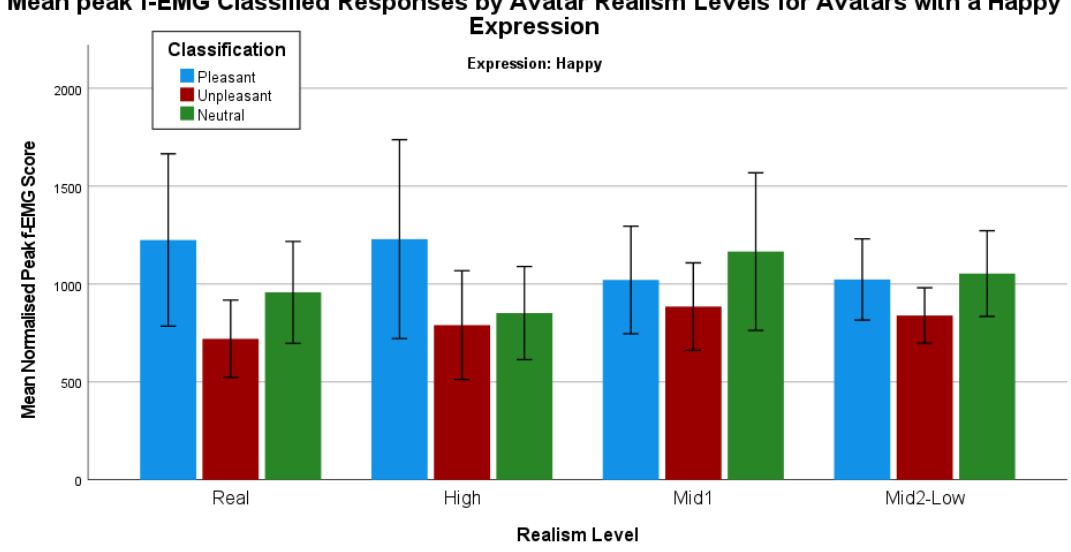
Figure 8. Mean peak f-EMG classified responses by avatars with a happy expression grouped by realism level.